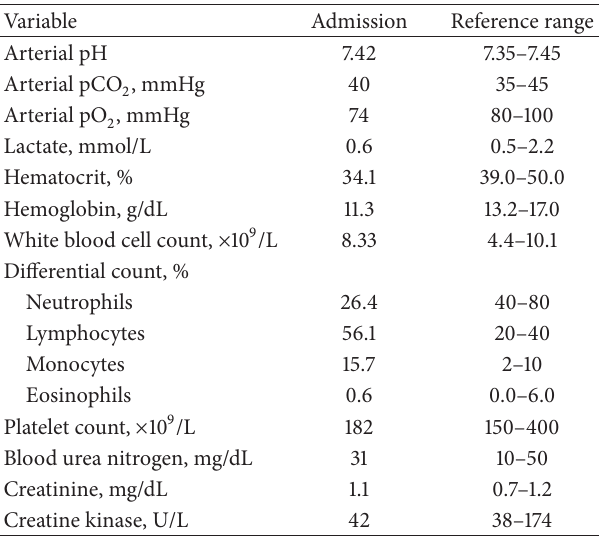
Table 1: Laboratory